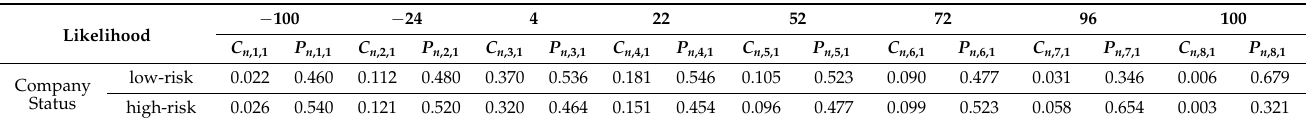
Table 2. Likelihoods of Operating Margin (%) rate for low-risk and high-risk